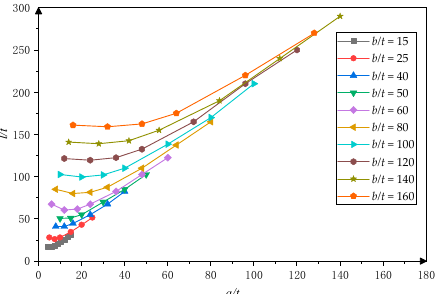
Figure 3. Values of l/t for different simple edge stiffener width − thickness ratios.